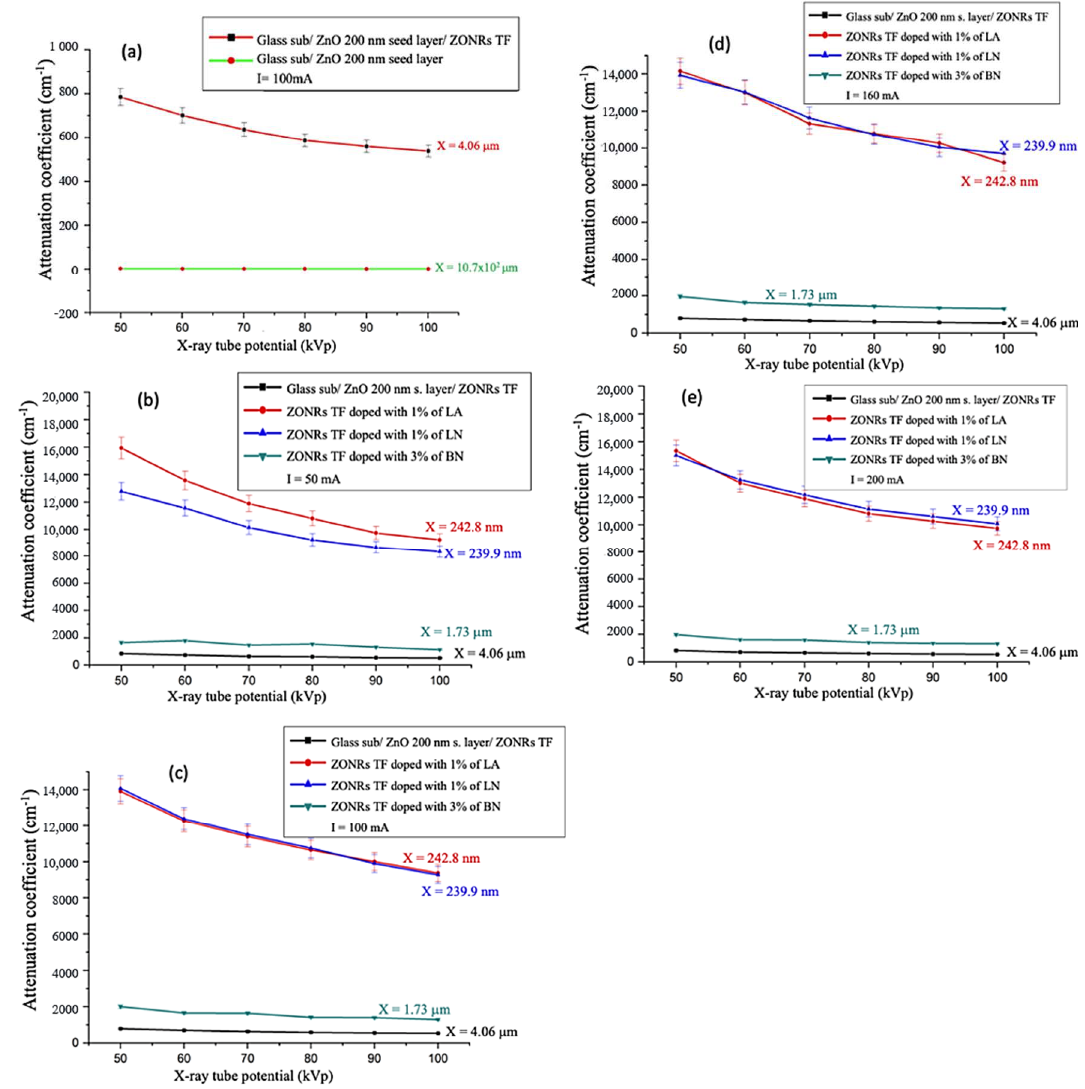
Figure 11. Irradiation energy dependent variation of µ for 200 nm-thick ZnO seed layer ( a ) undoped ZONRs-TFs obtained at tube current of 100 mA, ( b – e ) optimally doped ZONRs-TFs obtained at current (50 mA, 100 mA, 160 mA, and 200